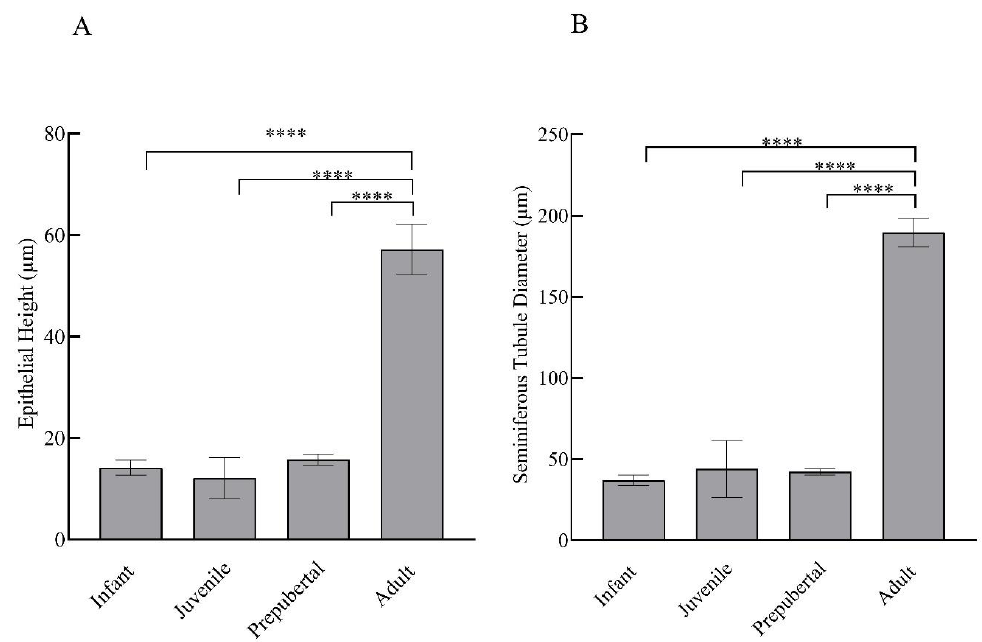
Figure 3. Mean ± SEM epithelial height per tubule ( A ) and seminiferous tubular diameter ( B ) of male rhesus monkeys through postnatal development. **** p < 0.0001. Animals 2022 , 12 , x 3.3. Developmental Variation in Number of GnIH-ir Terminals Expression Fluorescence